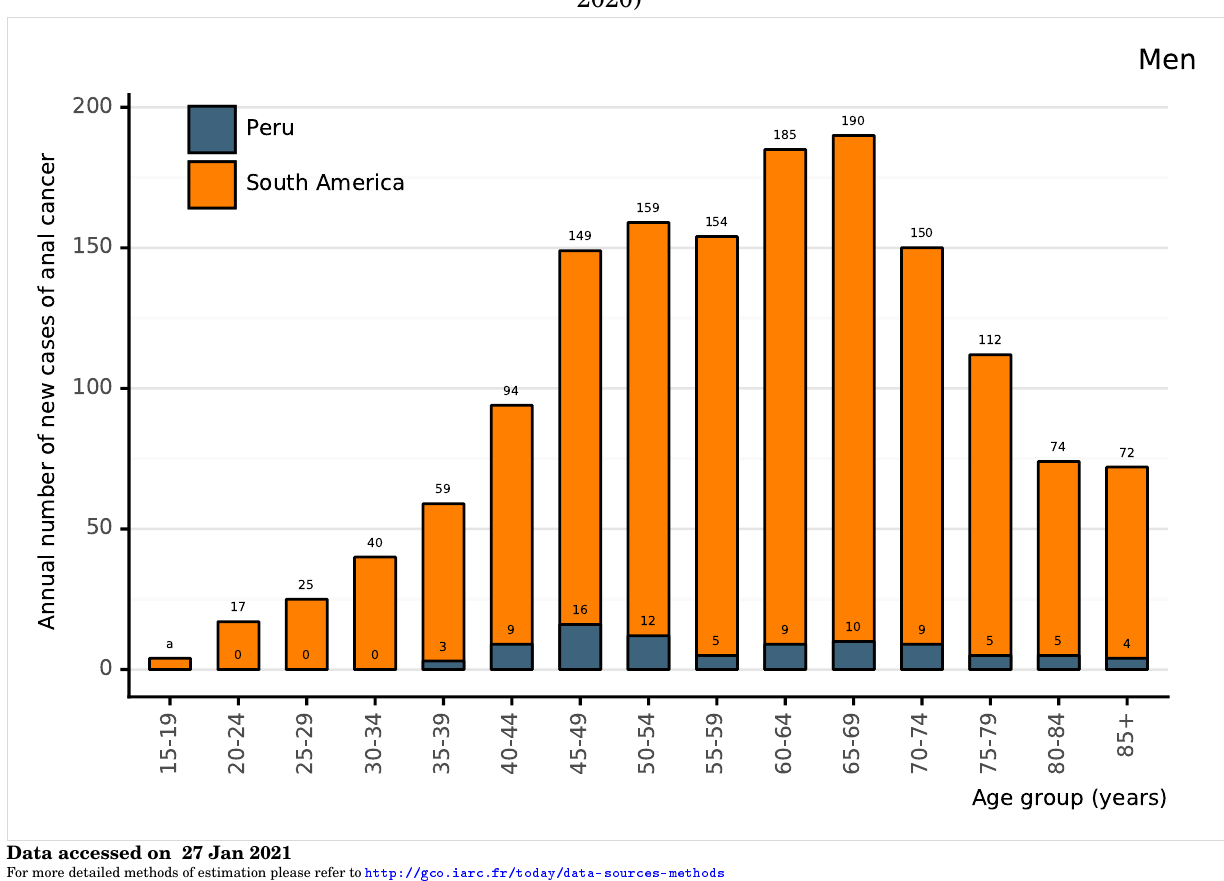
Figure 77: Annual number of new cases of anal cancer among men by age group in Peru (estimates